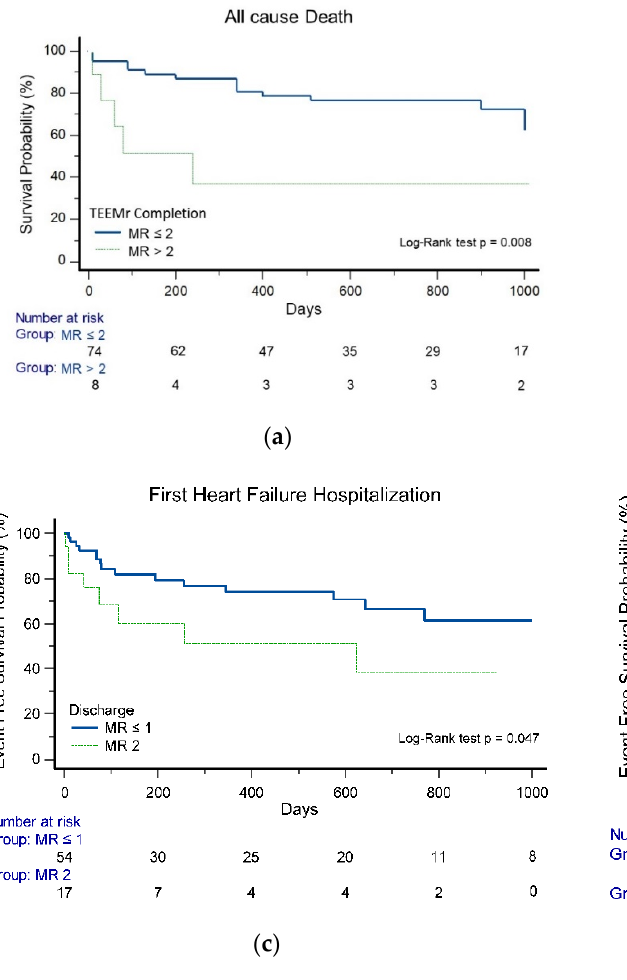
Figure 5. Kaplan-Meier analyses for clinical endpoints. ( a ) Survival probability stratified by Immediate post-procedural rMR grade; ( b ) Survival probability stratified by rMR grade at discharge; ( c ) Freedom from first heart failure related hospitalization stratified by rMR grade at discharge; ( d ) Freedom from death or first heart failure related hospitalization stratified by rMR grade at discharge. Table 3. ( a ) Univariable and multivariable Cox Proportional Hazards Regression Analysis for the occurrence all cause Death. ( b ) Univariable and multivariable Cox Proportional Hazards Regression Analysis for the occurrence all cause death or heart failure related